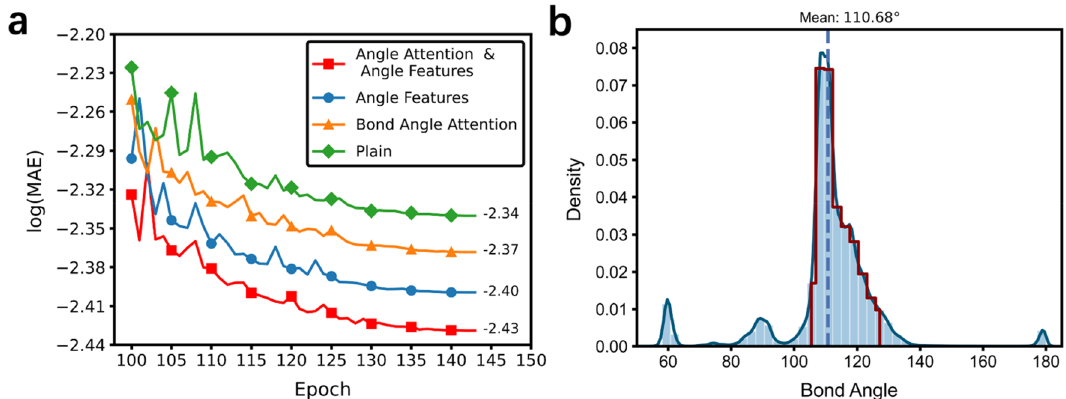
Figure 5. Four contrastive loss curves about angles and statistical distribution of bond angles. ( a ) Loss curves of four contrastive experiments. The lower loss means the higher accuracy. The red loss curves show the best of prediction performances among four contrastive experiments. ( b ) The statistical distribution of bond angles about small molecules with up to 30 carbon atoms. The bond angles concentrate between 103° and 126° in the red